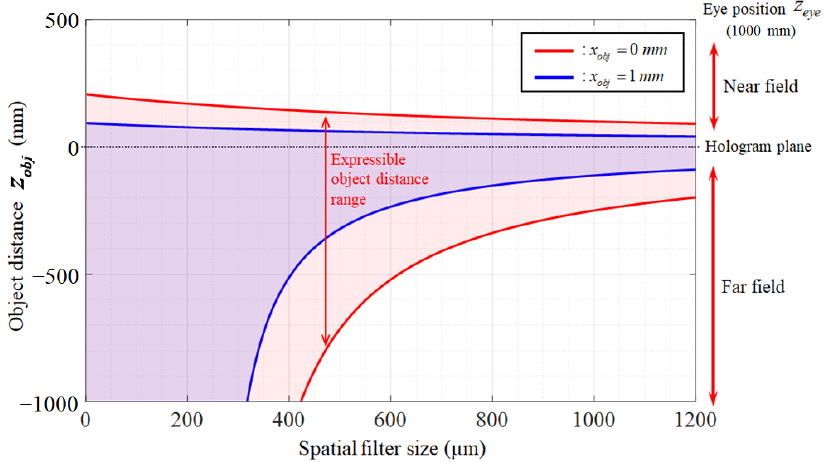
Figure 6. Expressible object distance range depending on the spatial filter size.